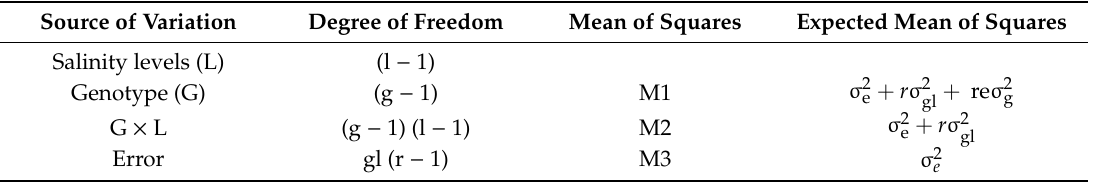
Table 1. Analysis of variance and expected mean of